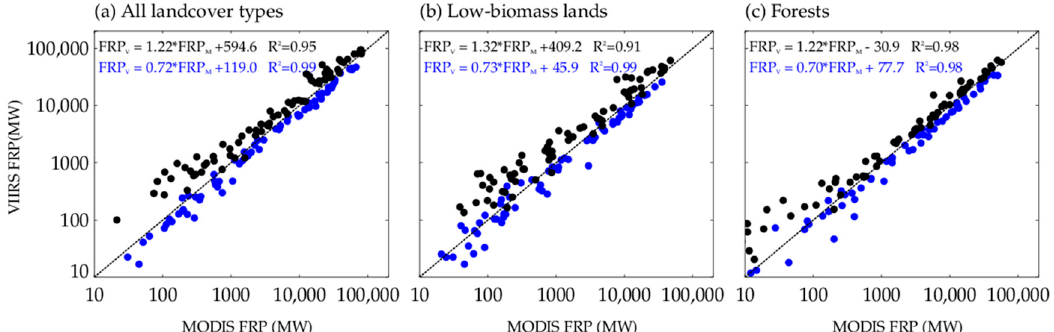
Figure 10. Scatter plots of the monthly total FRP of VIIRS versus MODIS. ( a ) all land cover types, ( b ) low-biomass lands, ( c ) forests. Black dots are the monthly total FRP summed from all detected fires in fire products; blue dots are the monthly total FRP summed from concurrently detected fires.